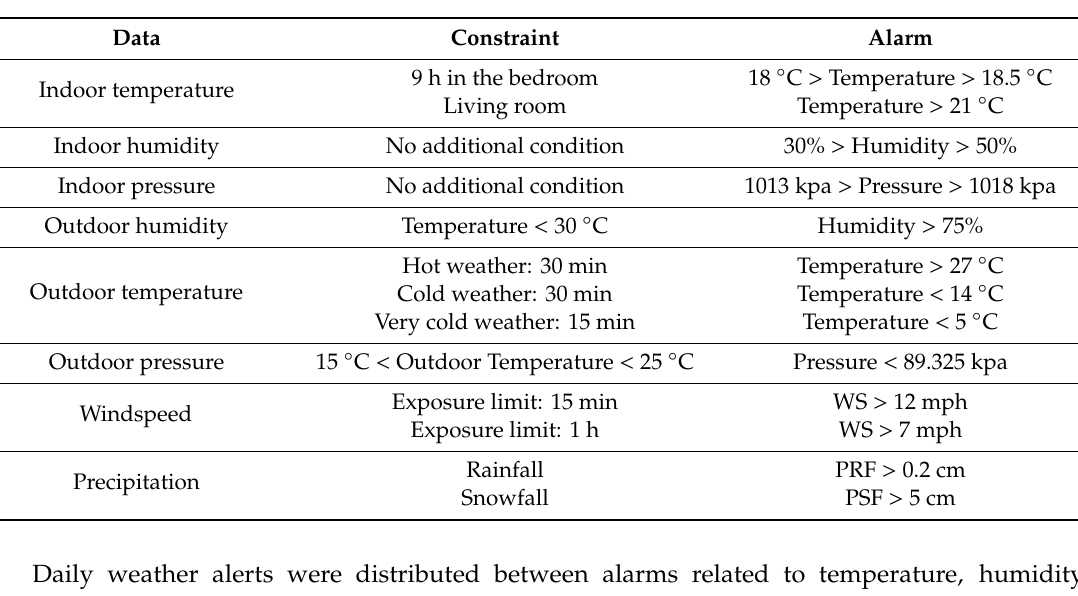
Figure 22. Number of alarms when the pollution index is dangerous. Table 10. Weather alarms and constraints for a specific profile. Table 12. Weather alarms and constraints for a specific profile.